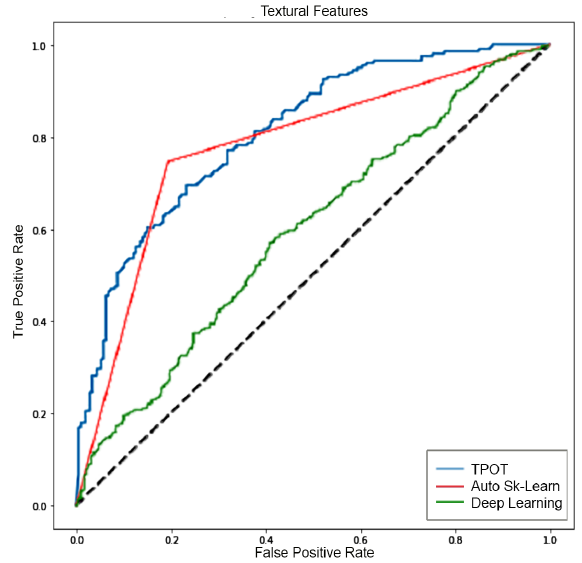
Figure 14. Comparison of ROC curves for the three machine learning approaches trained with textural